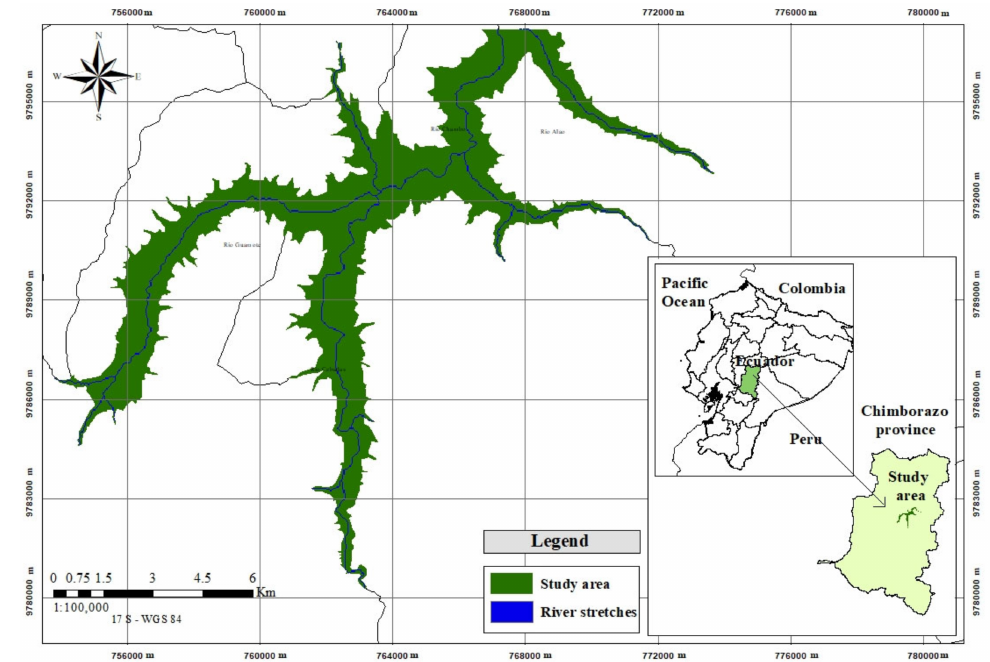
Figure 1. Location map of the study